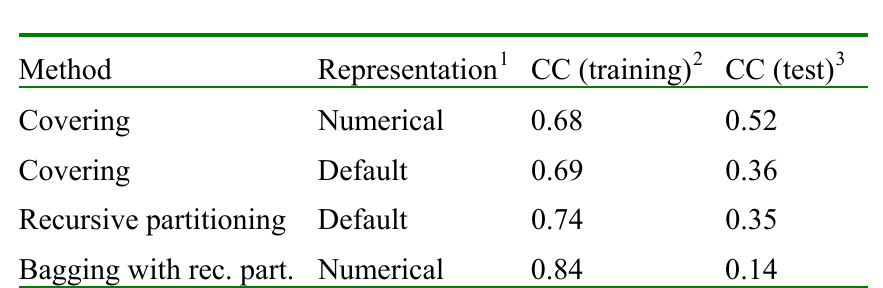
Table 1 . Prediction performance on zinc fingers using a selection of methods and data representations (320 data points in training data, 14 data points in test data). Note that the recursive partitioning-based methods suffer from heavy overfitting: the training set results are much better than the test set